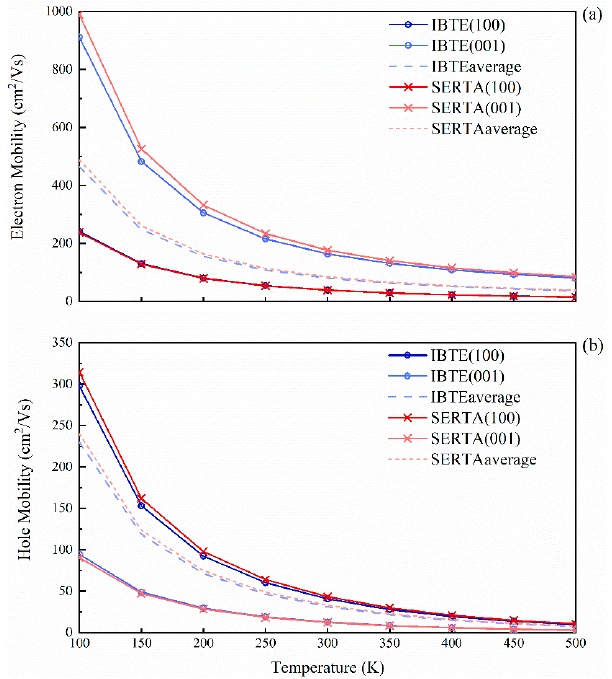
Figure 7. Calculated carrier drift mobilities of SrCu 2 O 2 as a function of temperature: ( a ) electron mobilities and ( b ) hole mobilities. The line with “ o ” represents using IBTE, and the line with “x” represents using SERTA, while the dashed line indicates the average values of the mobilities.